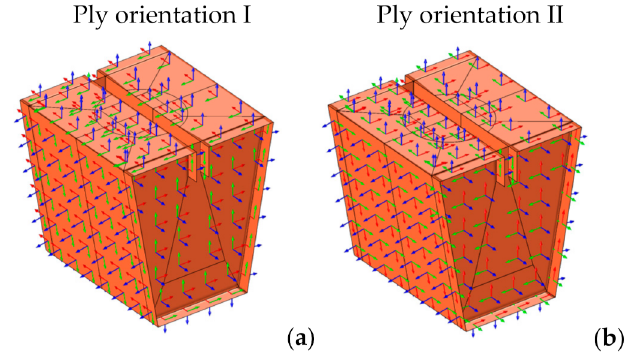
Figure 11. 1st design with top discontinuity (red: MD; green: CD). Ply orientation: ( a ) I; ( b ) II.